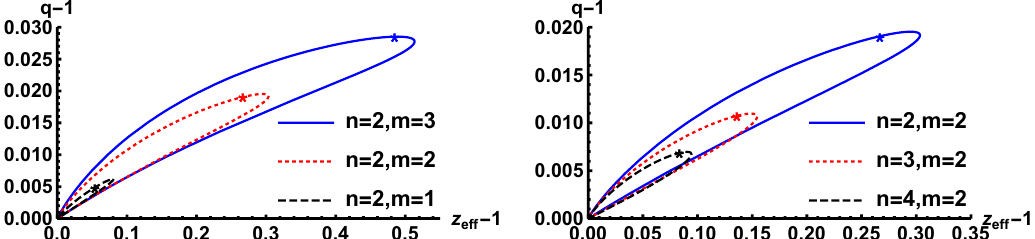
Figure 8 . We present the internal squashing function versus the e(cid:11)ective exponent for Lifshitz (cid:13)ows. Left: the curves correspond to (cid:12)xed n = 1 = 3 and m = 1 (dashed black), m = 2 (blue), and m = 3 (dotted red). Right: the curves correspond to (cid:12)xed m = 2 and varying n = 1 = 3 (blue), n = 1 = 2 (dotted red), and n = 2 = 3 (dashed black). In both panels we have (cid:12)xed Q f = 1. The RG (cid:13)ows clockwise.